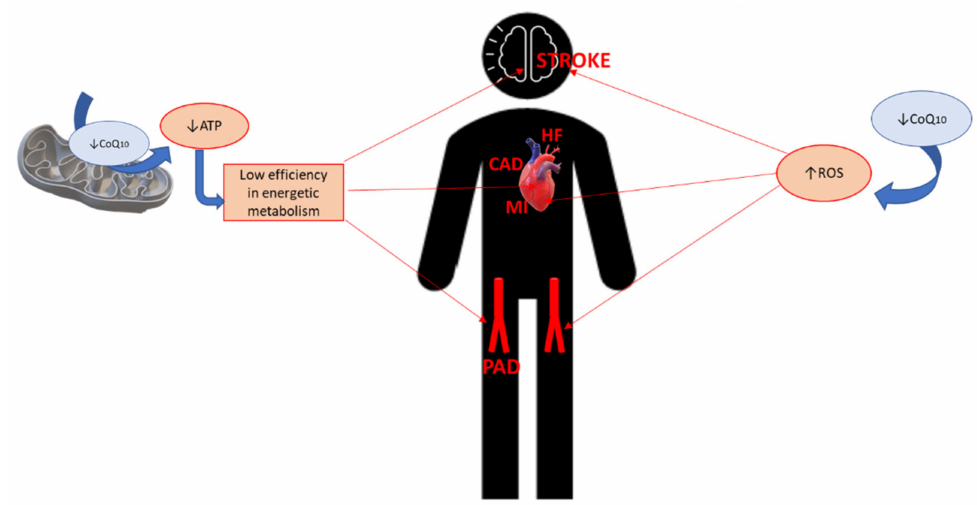
Figure 1. Pathogenic background of coenzyme Q10 in cardiovascular diseases. CoQ 10 : Coenzyme Q 10 ; ATP: Adenosine triphosphate; CAD: Coronary artery disease; HF: Heart failure; MI: Myocardial infarction; PAD: Peripheral artery disease; ROS: Reactive oxygen